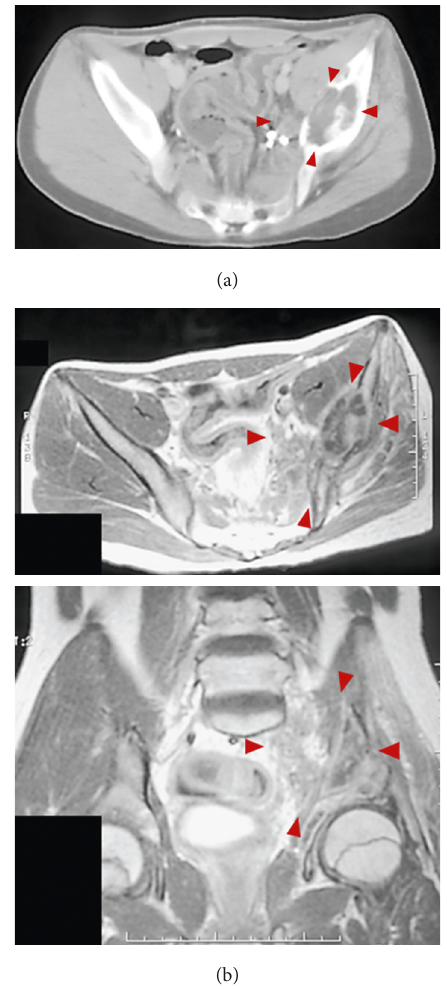
Figure 5: (a, b) The tumor volume was reduced successfully and judged as partial response (PR).